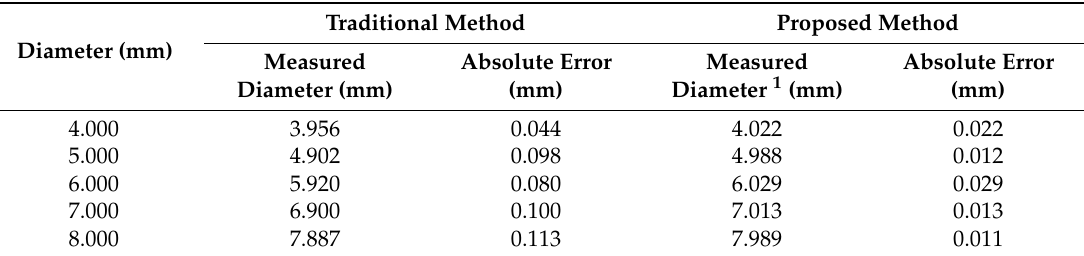
Table 3. Experimental data on metal